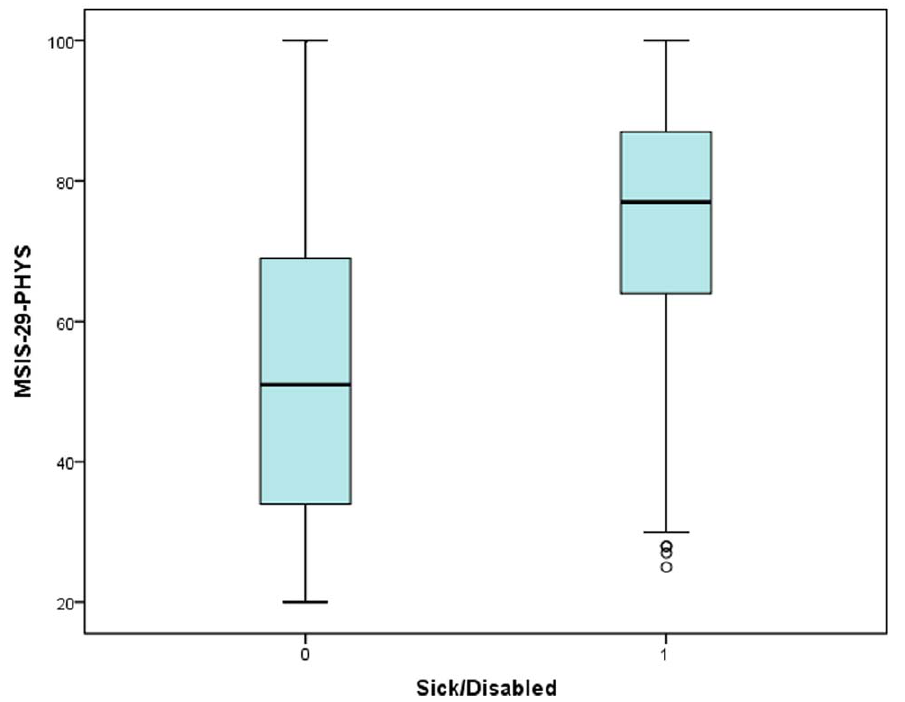
Figure 4. The MSIS-29-PHYS scores for people of workforce age. The scores of people who report they are sick/disabled (=1) were compared with those who are not sick/disabled (=0).